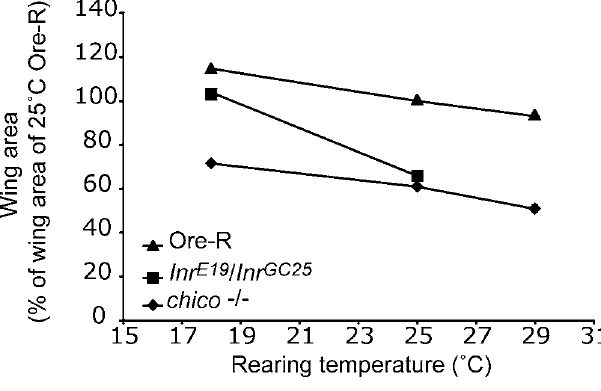
Figure 1. Temperature Sensitivity in Inr E19 /Inr GC25 Flies Increasing the rearing temperature of Inr E19 / Inr GC25 females from 18 8 C to 25 8 C causes a reduction in wing area from approximately wild-type (Oregon-R [Ore-R]) to that of an insulin pathway mutant (chico) . Wing size is expressed as percentage area of Oregon-R female wing at 25 8 C. No Inr E19 /Inr GC25 flies survived rearing at 29 8 C. The standard errors are smaller than the markers. DOI: